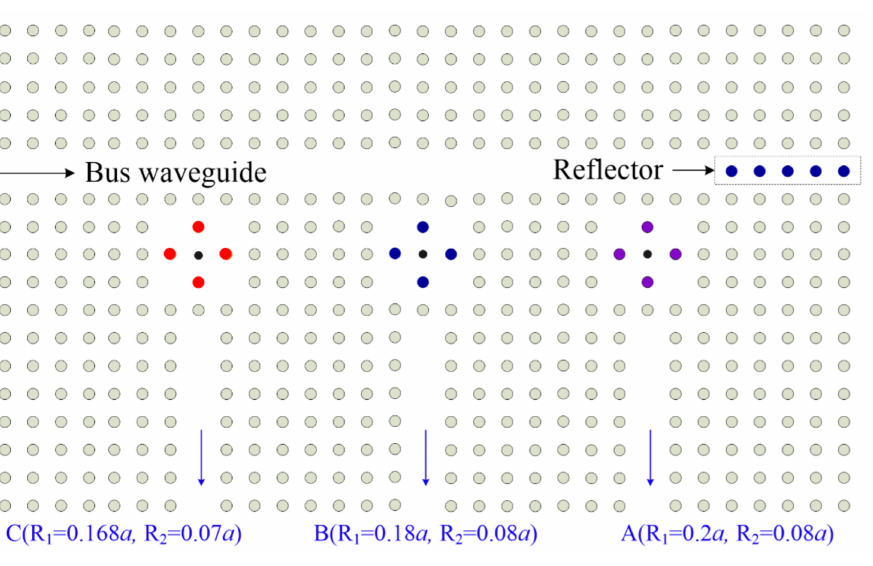
Figure 2. Structure diagram of the three-channel photonic crystal